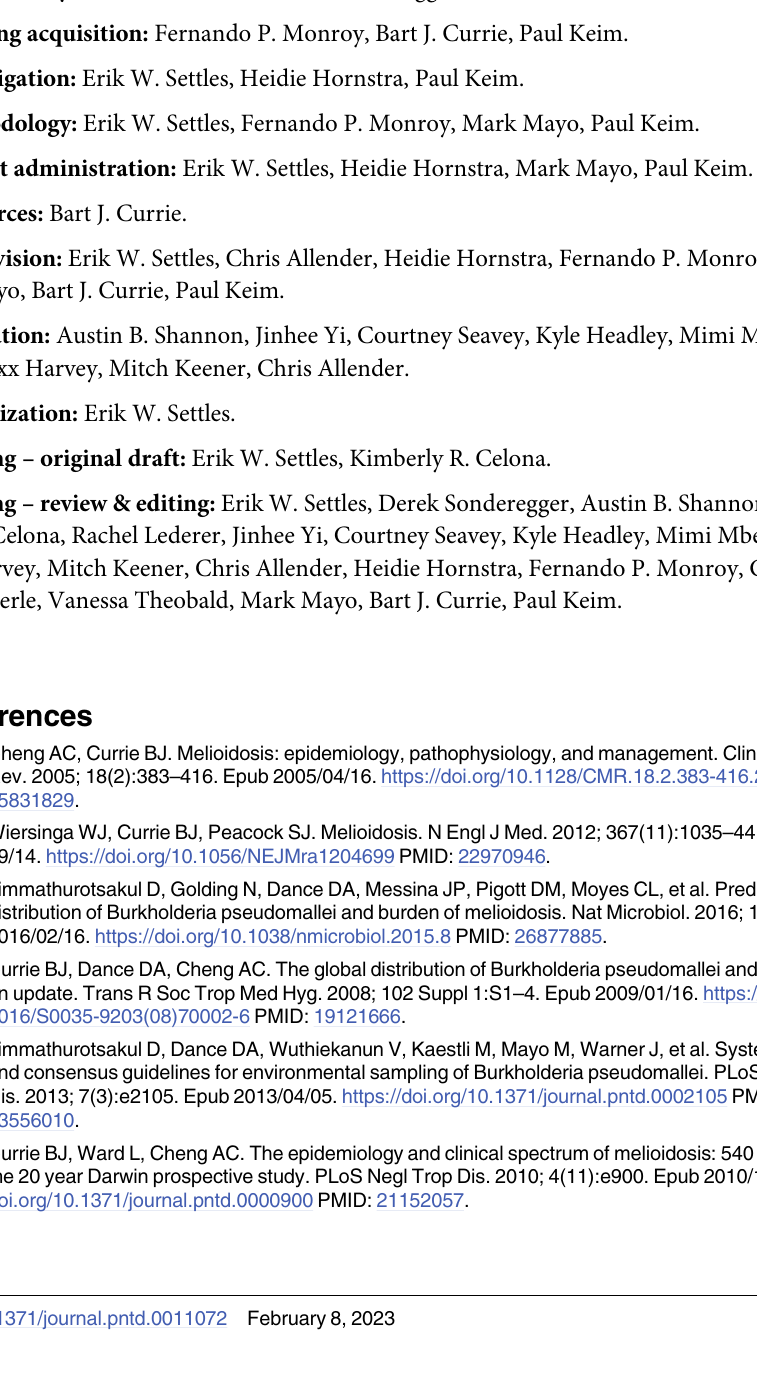
S3 Table. MAGPIX Median Florescence data. DPMS = Darwin Prospective Melioidosis Study.